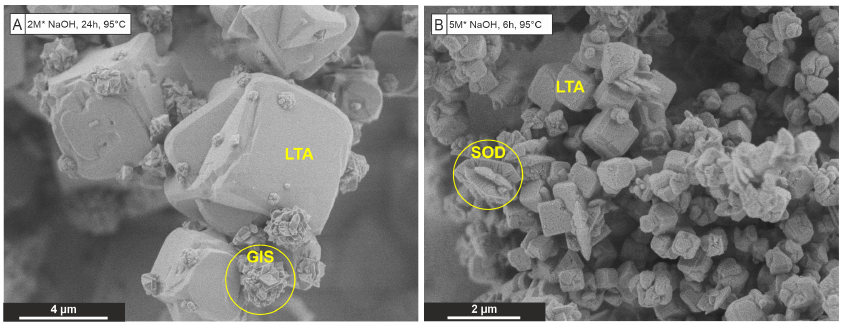
Figure 6. Characterization of zeolites obtained from the hydrothermal synthesis step. SEM-SEI of solids obtained from experiments S3 ( A ) and S5 ( B ) reveal the dominance of LTA-zeolites with minor GIS- and SOD-zeolites (highlighted with yellow